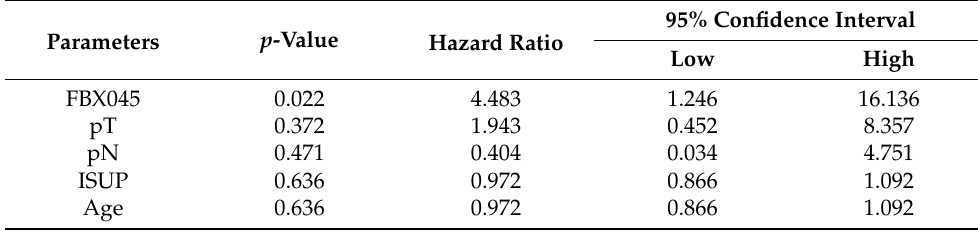
Table 1. Multivariate Cox regression analyses of the T2E-positive subgroup (TMA cohort) regarding progression-free survival (PFS).